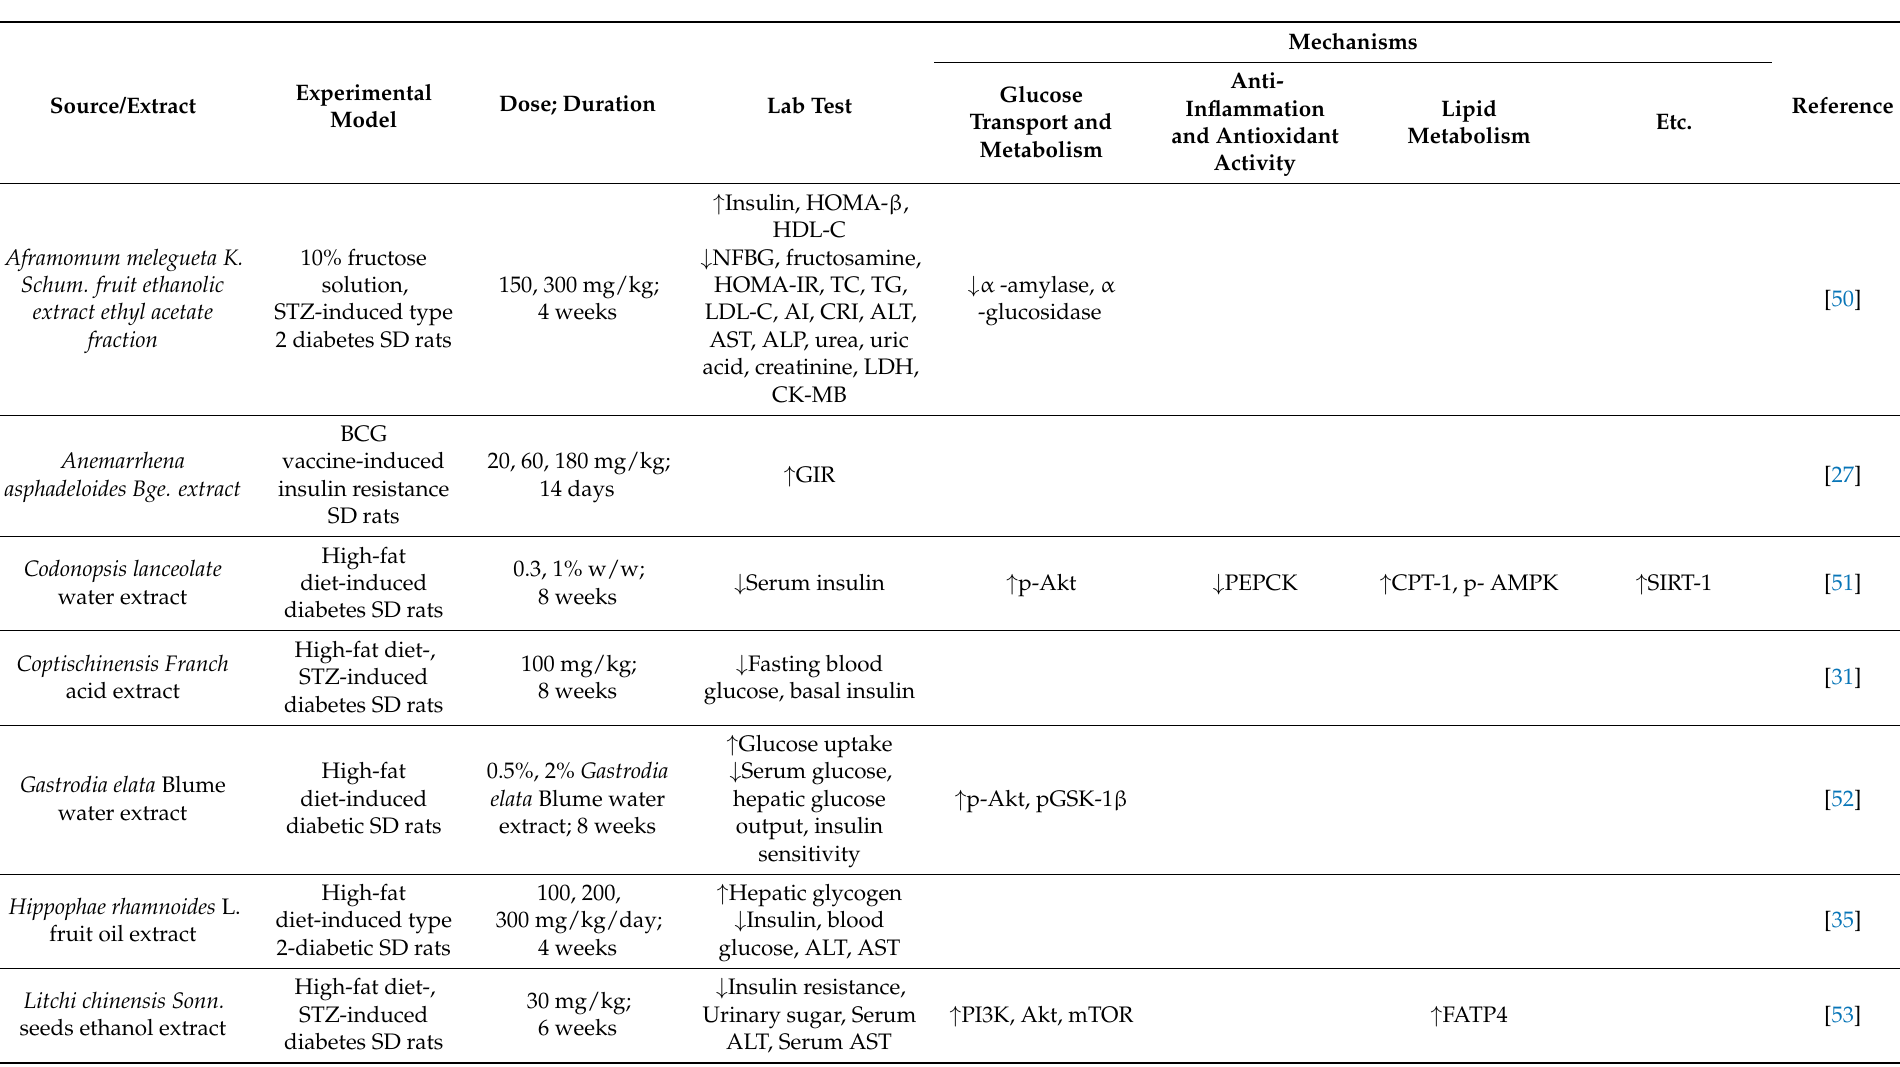
Table 2. In vivo studies—SD